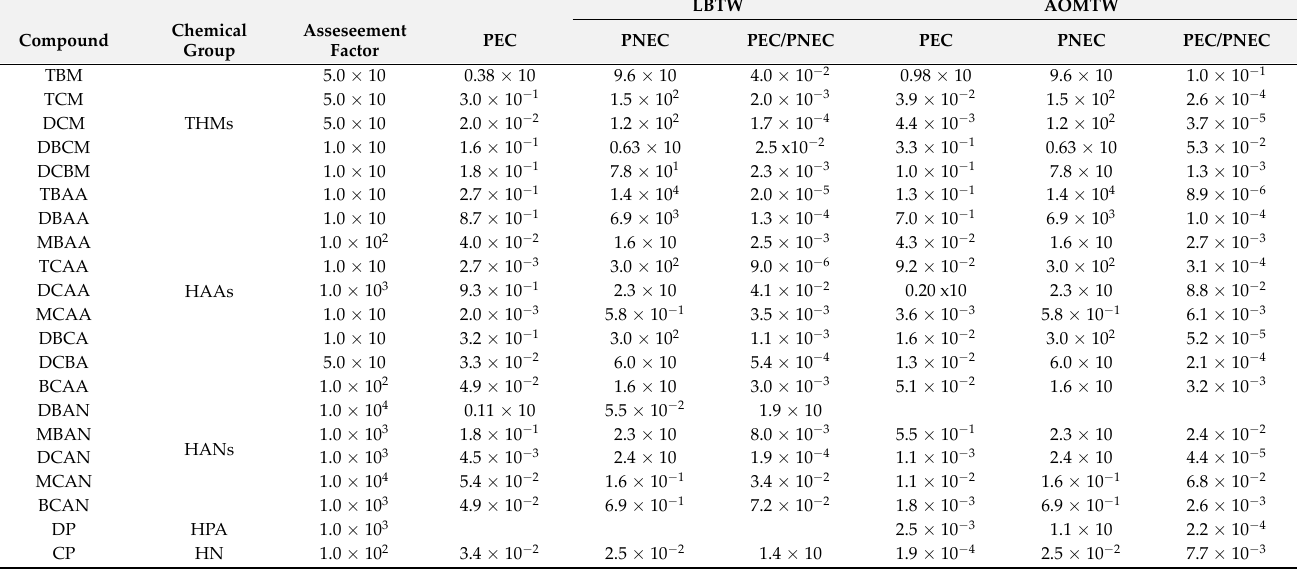
Table 5. Predictive environmental concentration (PEC) for the surrounding conditions as calculated using MAMPEC 3.1, the predictive no‑effect concentration (PNEC) as calculated using the lowest toxicity data and the assessment factor (AF) from the IMO, GISIS, and the PEC/PNEC ratio of THMs, HAAs, and HANs detected in both the land‑based test water (LBTW) and algal organic matter test water